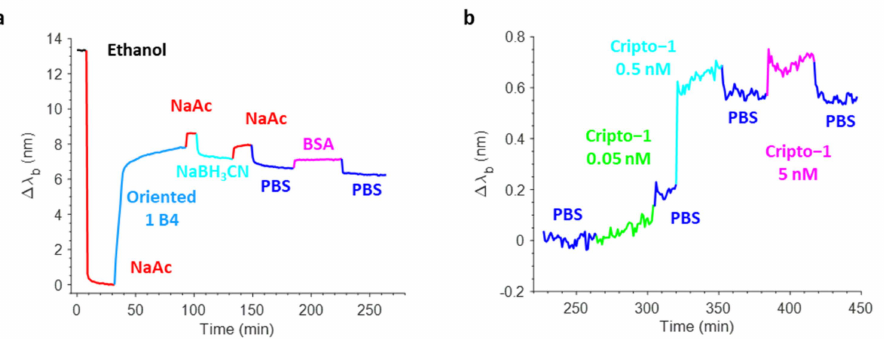
Figure 8. Real-time sensorgram showing the variations in the barycentric wavelength of the resonance of an OFMT during the biofunctionalization phase ( a ). Sensorgram related to the detection of Cripto-1 at increasing concentrations in PBS in the range 0.05–5 nM ( b